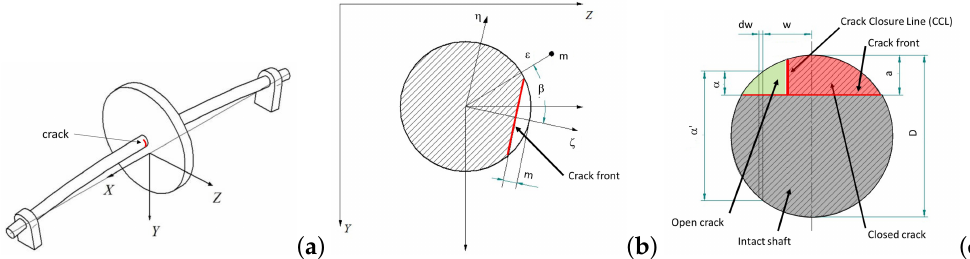
Figure 1. Jeffcott Rotor model: ( a ) schematic configuration, ( b ) fixed and rotary coordinate sys- tems, ( c ) cracked section. Source: Reprinted/adapted with permission from [38]. 2012, Springer Science+Business Media